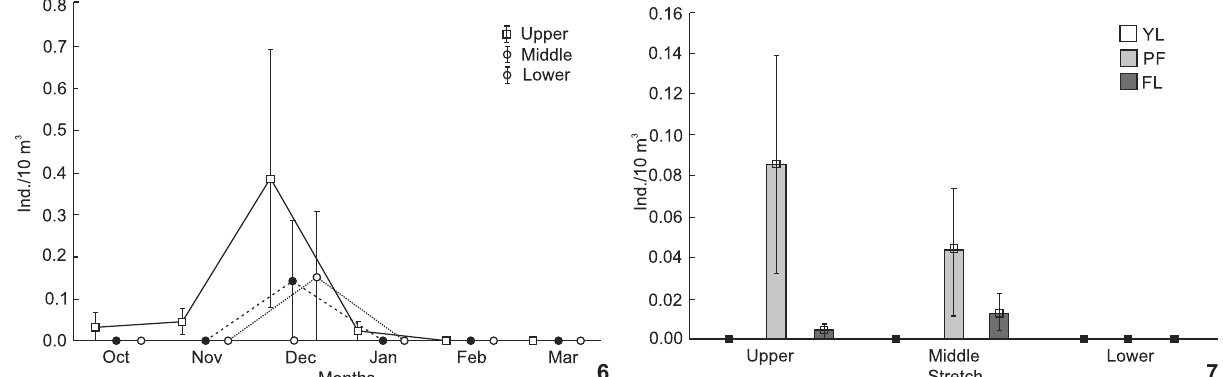
Figures 6-7. Spatial and temporal variation in the mean density of Pseudoplatystoma corruscans (6) and of development stages (7) (YL: yolk-sac, PF: preflexion, FL: flexion) in the region of Ilha Grande National Park, in Paraná